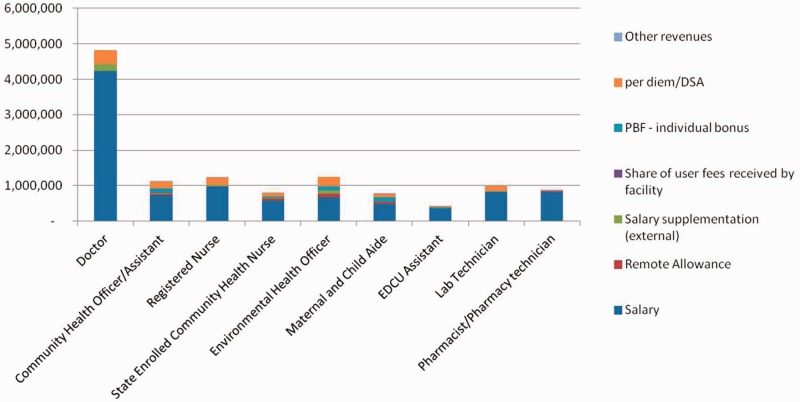
Breakdown of sources of primary income, by professionSource:
Witter et al. 2014a.